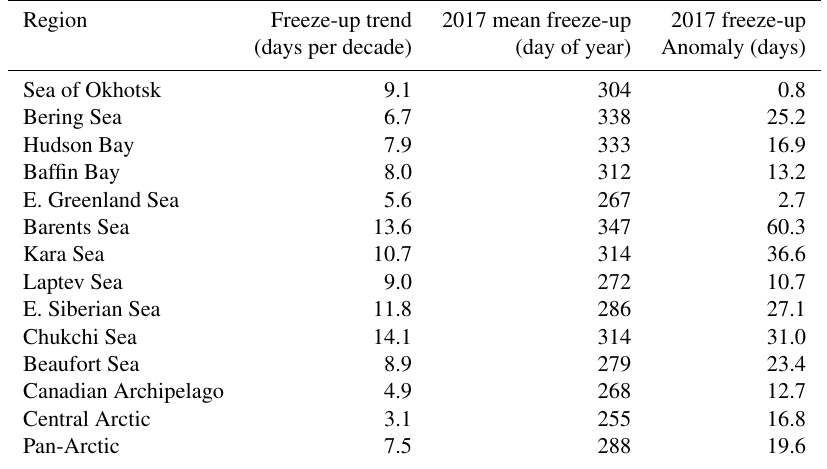
Table 1. Regional trends in freeze-up, 2017 freeze-up date and anomaly (relative to 1981–2010 mean). Freeze-up is computed following Markus et al. (2009).